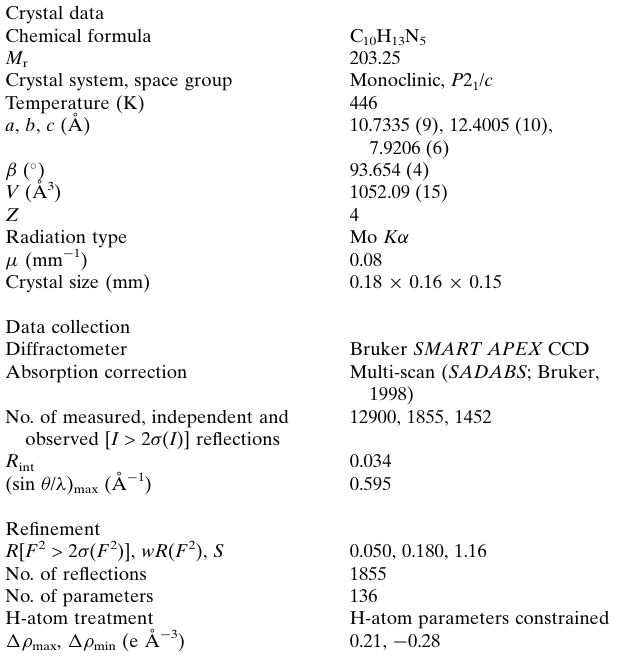
Table 2 Experimental details.